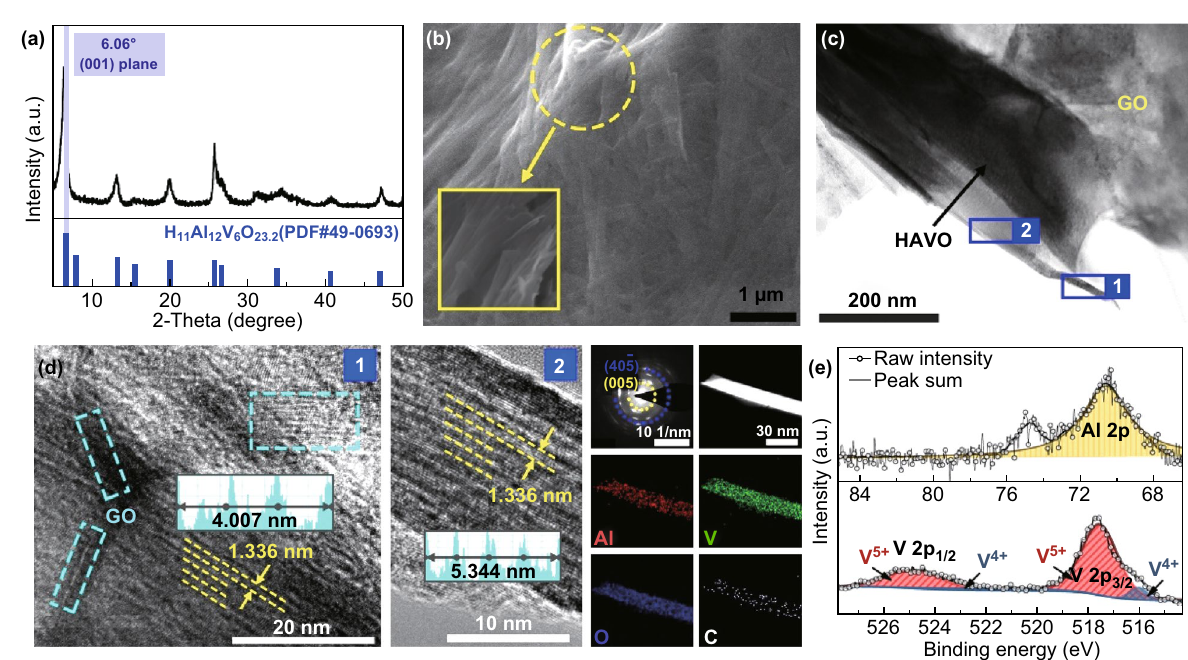
Fig. 1 a XRD pattern, b SEM image, c TEM image, d HRTEM images with SAED pattern and TEM-EDS element mappings, and e High- resolution XPS spectra with Al and V elements of